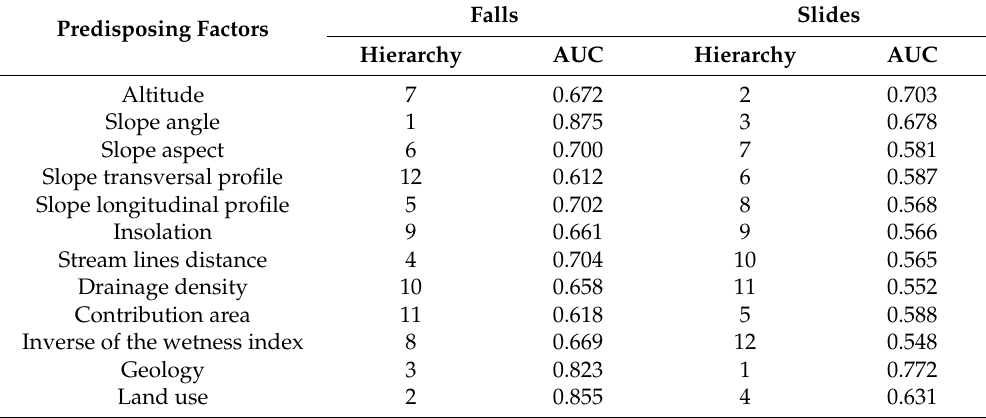
Table 4. Areas Under the Curve (AUC) for the Success Rate Curves (SRCs) and the hierarchy of each predisposing